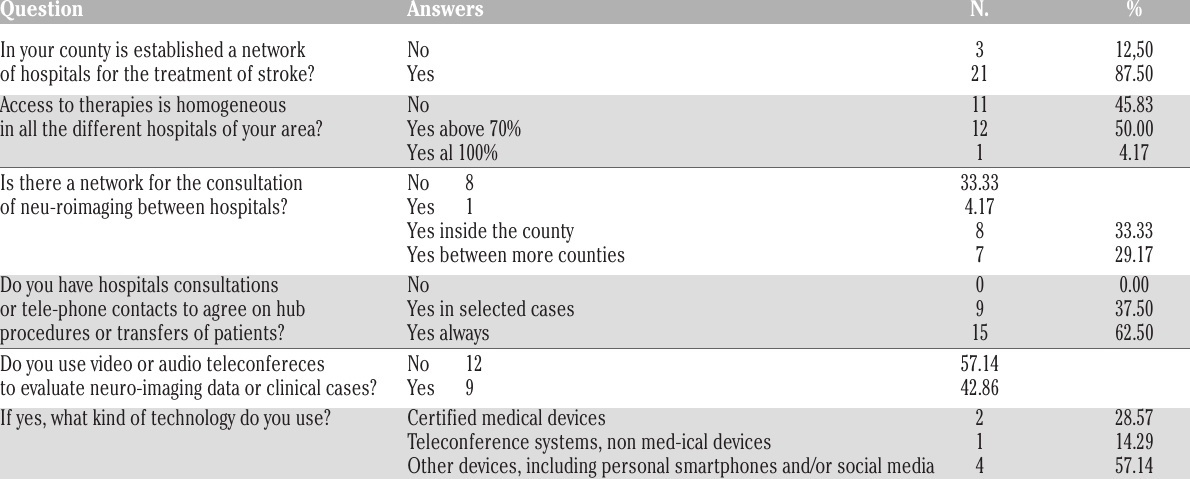
Table 2. Questionnaire answers